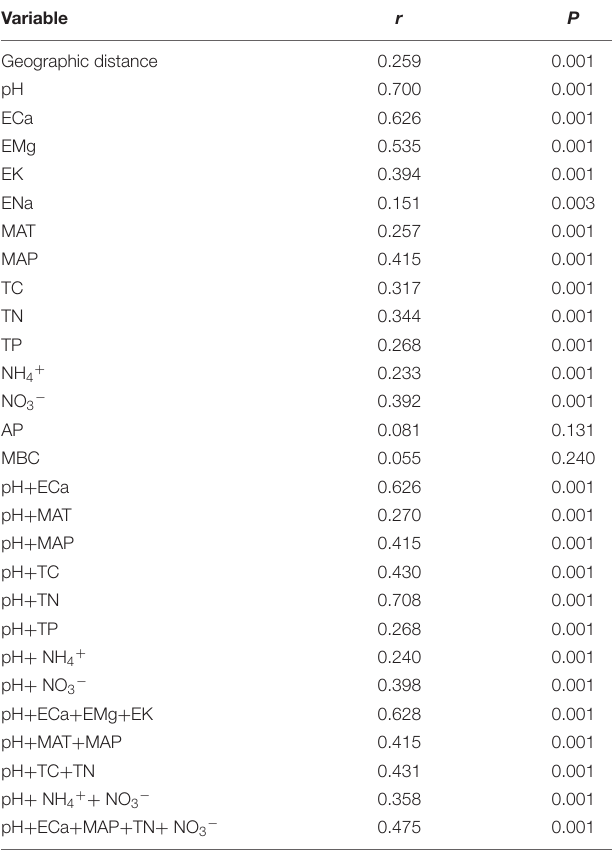
TABLE 4 | Correlations between “Bray–Curtis” distance of bacterial community composition and geographic or environmental variables distance using Mantel